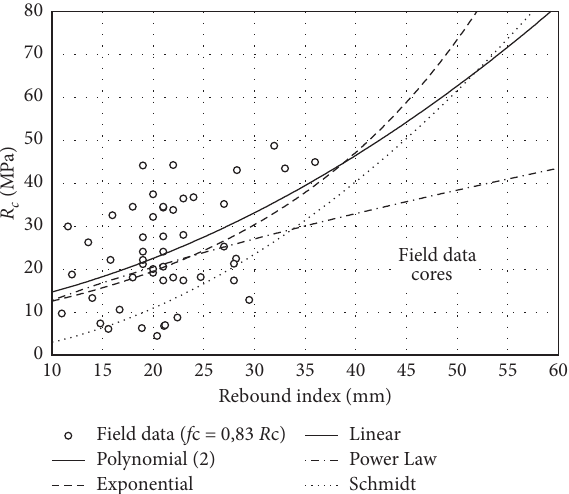
Figure 10: Different calibration curves and field